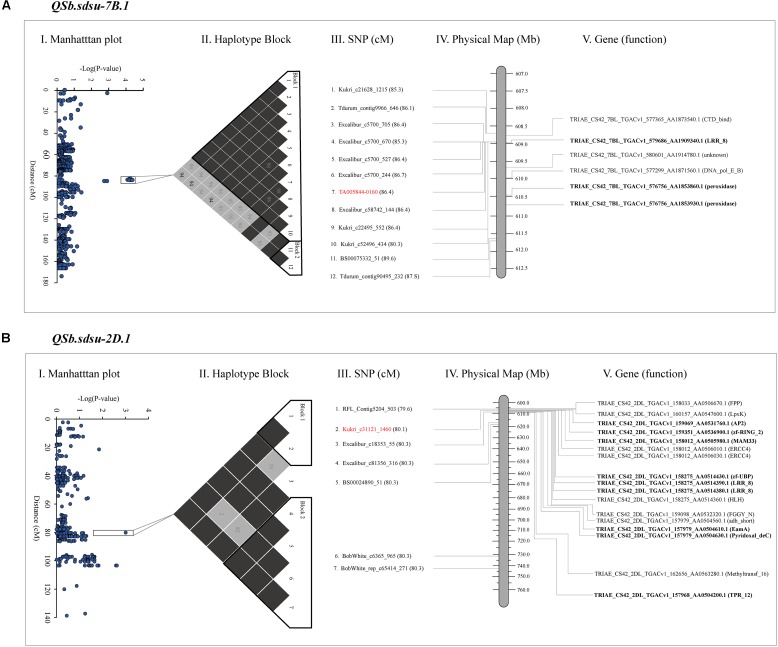
Gene annotation of QTLs identified on chromosome 7B (A) and 2D (B) for spot blotch resistance in hard winter wheat. The far left image is a Manhattan plot indicating the level of marker association with the trait (I). Next is a visualization of linkage disequilibrium (black is a D’ value of 100%, another color is a D’ value of less than 100%), significant haplotype blocks are outlined in black (II). Names of the markers in the region of interest along with their cM position (III), and physical position (IV). Most significant marker is highlighted in red. The far right image is a physical map of candidate genes on 7B and 2D chromosome segments spanning from 608.7 to 611.7 Mb and 606.9 to 608.8 Mb, respectively (IV and V). Genes in bold code Pathogenesis-related (PR) proteins. The cM position is based on Wang S. et al. (2014) and the physical position is based on IWGSC 2018.